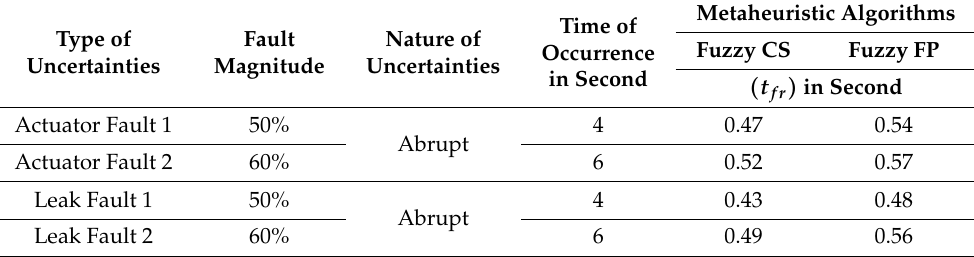
Table 5. Comparative results of fault recovery time ( t fr ) for TTCFNLC system under two uncertain- ties found by fuzzy CS and FP algorithm using ST2FIS.